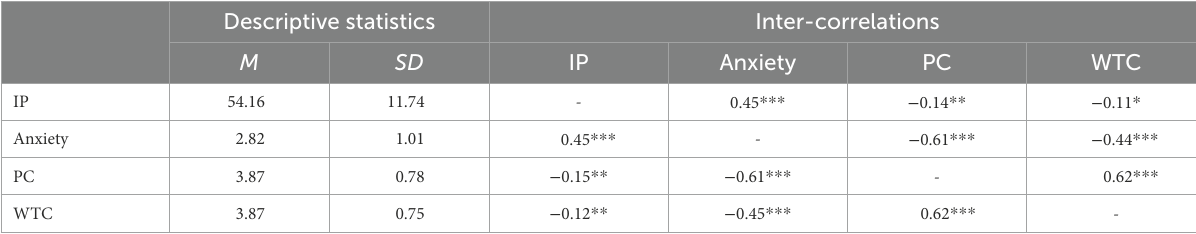
N = 400. Above diagonal zero-order correlations and below diagonal second-order correlations controlled for age and gender. * p < 0.05. ** p < 0.01. *** p < 0.001. Two-tailed. Harman’s one-factor test showed that 25.9% of the variance in the study variables were explained by a single factor, which is below the cut-off (50%) suggesting the existence of robust common method variance.